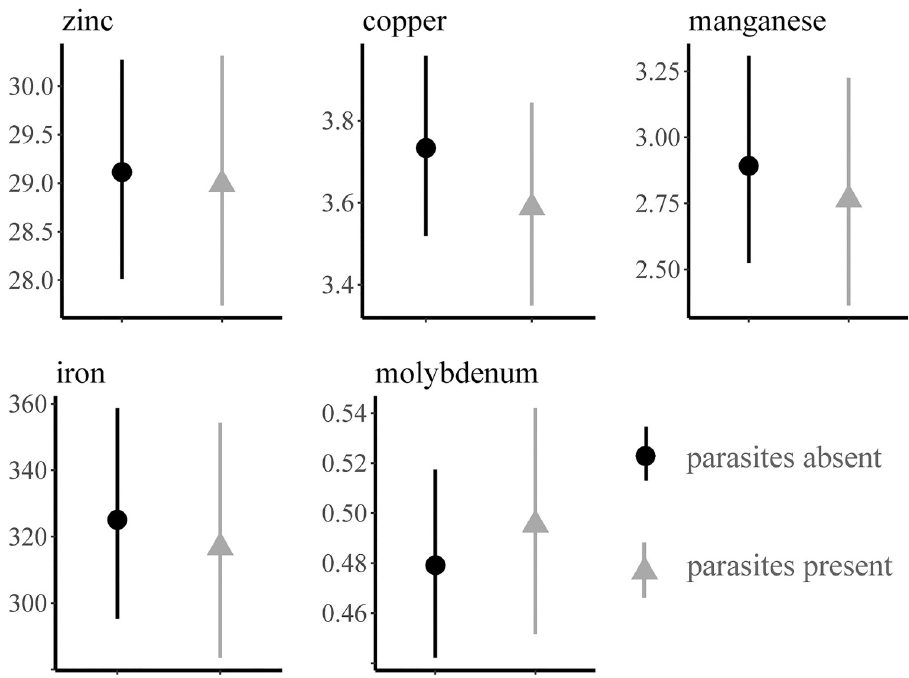
Fig 9. Mean liver concentrations (ppm, wet weight) of heavy metals in muskrats ( Ondatra zibethicus ) with respect to intestinal parasite presence and absence in Pennsylvania, USA, 2018–2019.